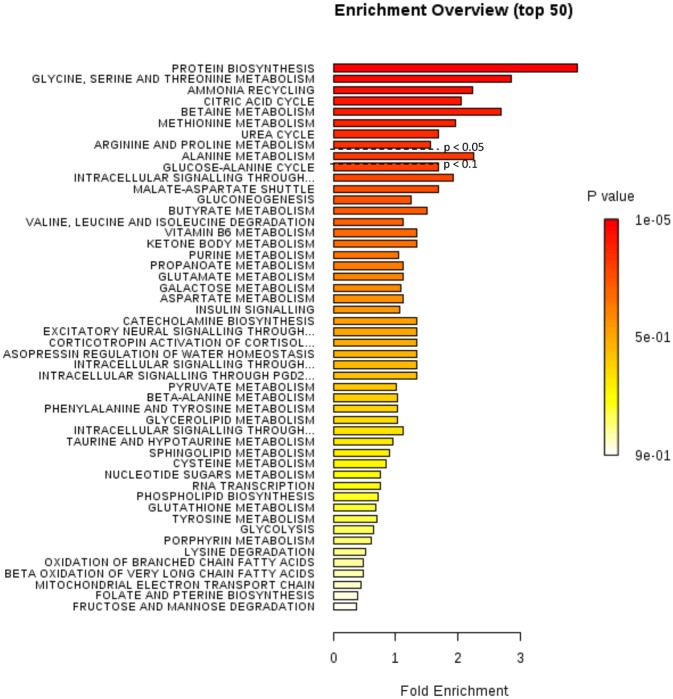
Metabolic pathway analysis demonstrated major impact in amino acid metabolism.Summary plot for metabolite set enrichment analysis (MSEA) where metabolite sets are ranked according to p-value with hatched lines indicating Holm p-value threshold. The top fifty metabolite sets are shown. The color code of the bar plot corresponds to the calculated P values.